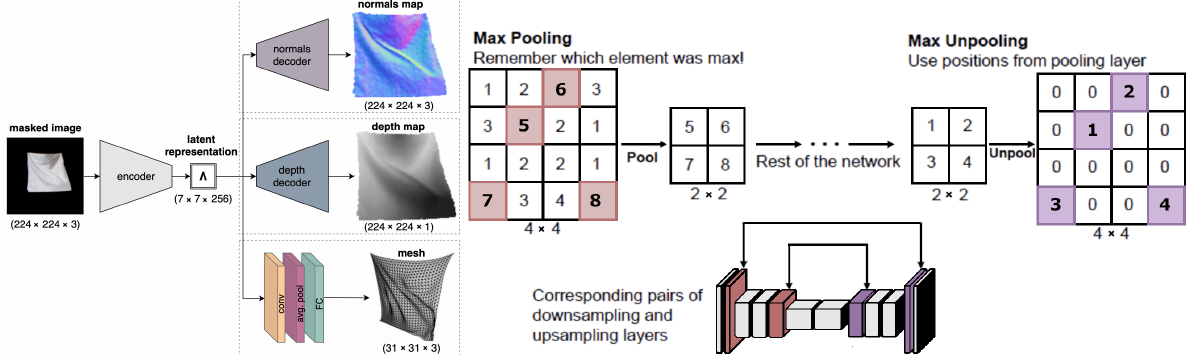
Figure 3. The textureless surface reconstruction network [3] ( left ) consists of an encoder Λ that takes a masked image I n m as input and outputs a latent representation Λ . This is followed by three parallel decoders Φ N , Φ D , and Φ C that use Λ for reconstructing the normal map, depth map, and a 3D mesh respectively. The indices of all maxpool operations in the encoder are saved when downsampling ( right ). These indices are later used for non-linear upsampling in corresponding decoder